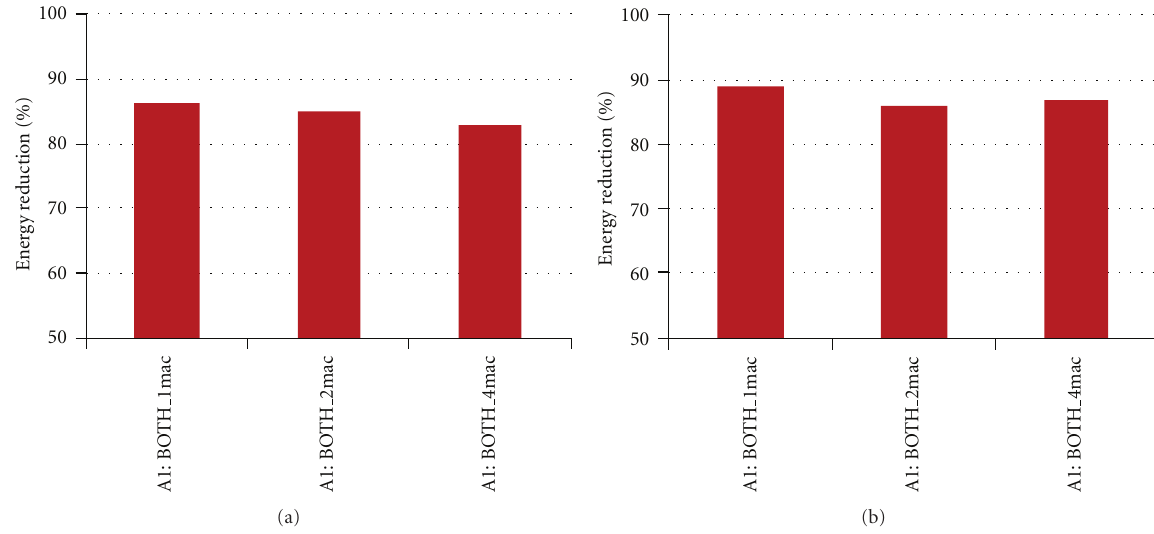
Figure 13: Energy savings in percent for hybrid A1, during adaptive switching (32-bit (a), 64-bit